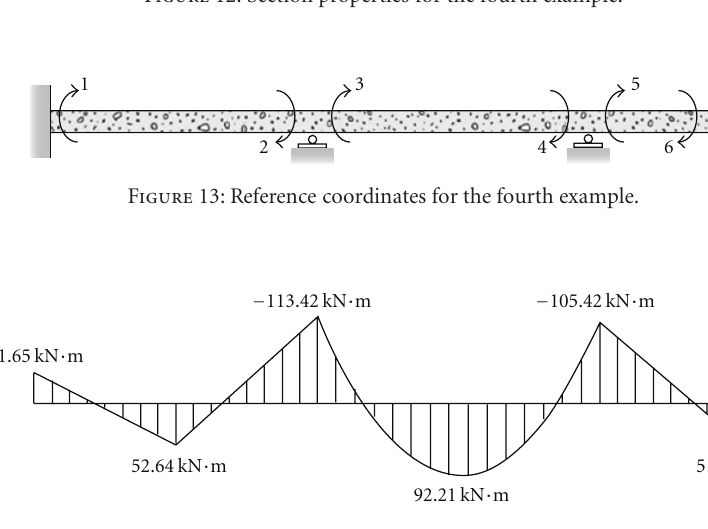
Figure 14: Bending moment diagram for the fourth